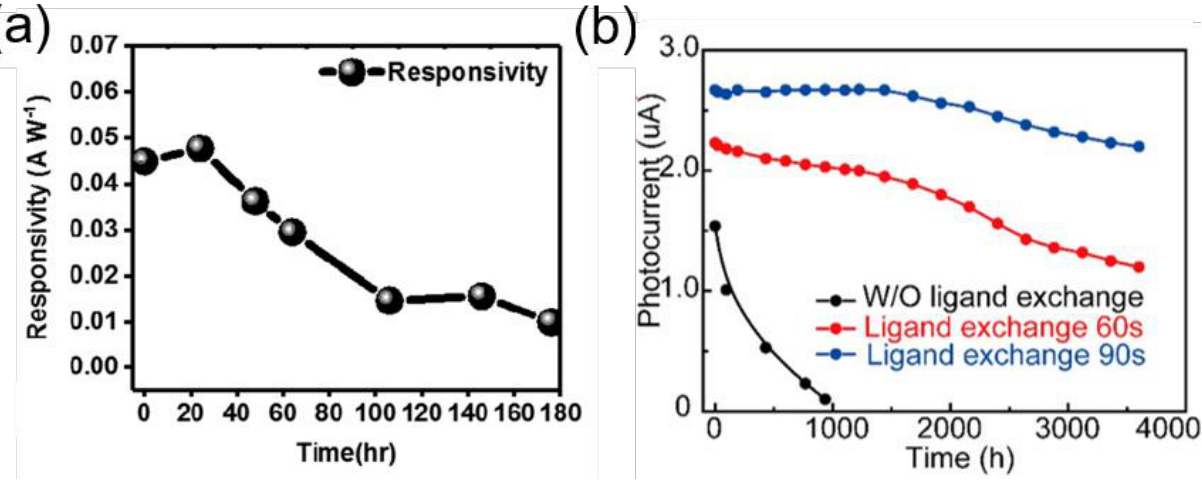
Figure 13. ( a ) Lifetime test of a photodiode with P3HT passivation layer under humid conditions (relative humidity of 80%) and continuous illumination (0.35 mW cm −2 at 520 nm) [76]. Copyright 2018 John Wiley & Sons, Inc. ( b ) Photocurrent measured on CsPbCl 3 /Graphene photodetector with and without MPA passivation under ambient conditions [7]. Copyright 2019 American Chemical Society.